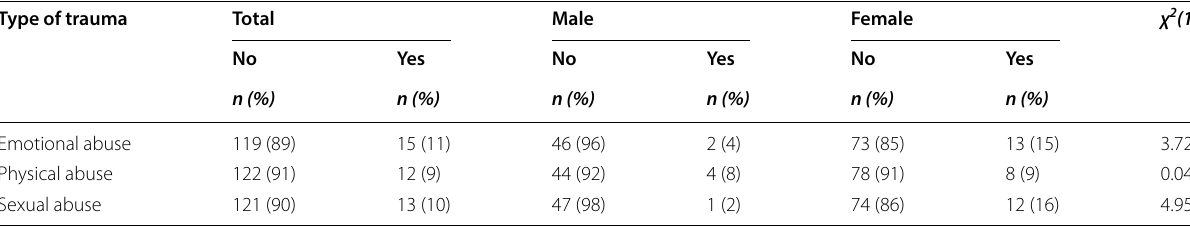
Table 1 Distribution of childhood trauma